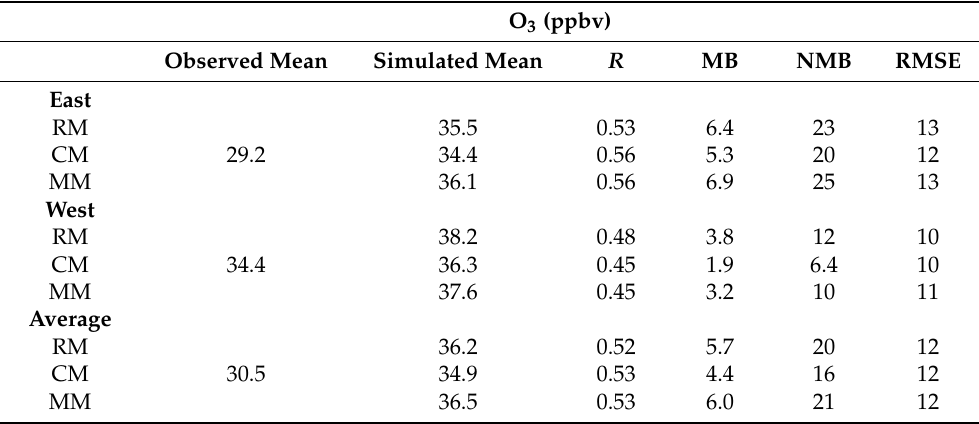
Table 4. Statistical analysis of predicted hourly O 3 concentrations for the RACM-MADE/SORGAM (RM), CBMZ-MOSAIC (CM), and MOZART-MOSAIC (MM) chemistry-aerosol mechanisms. All stations considered have ≥ 90% of available hourly data.